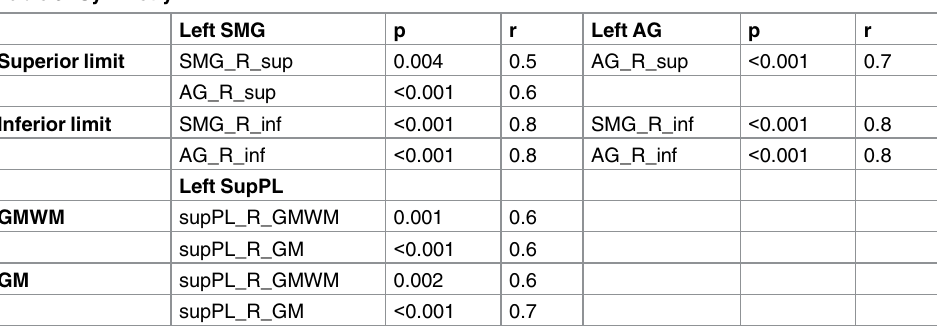
Table 6. Symmetry.